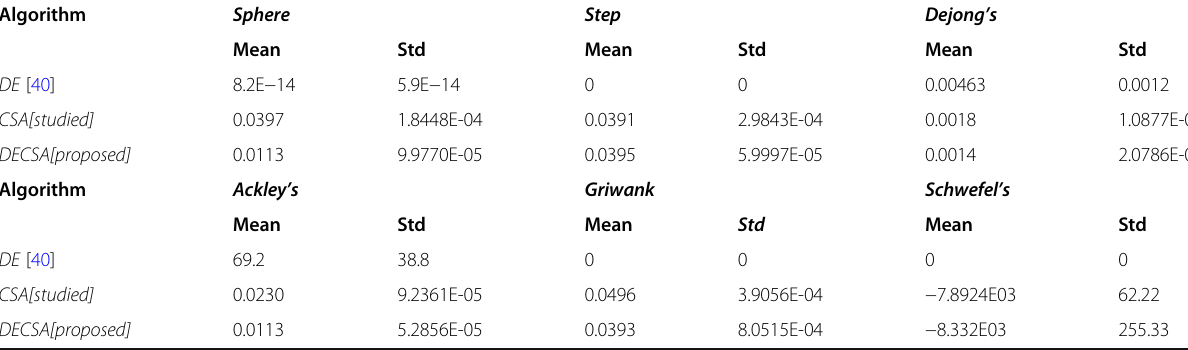
Table 4 Comparison of optimization results obtained for the benchmark functions